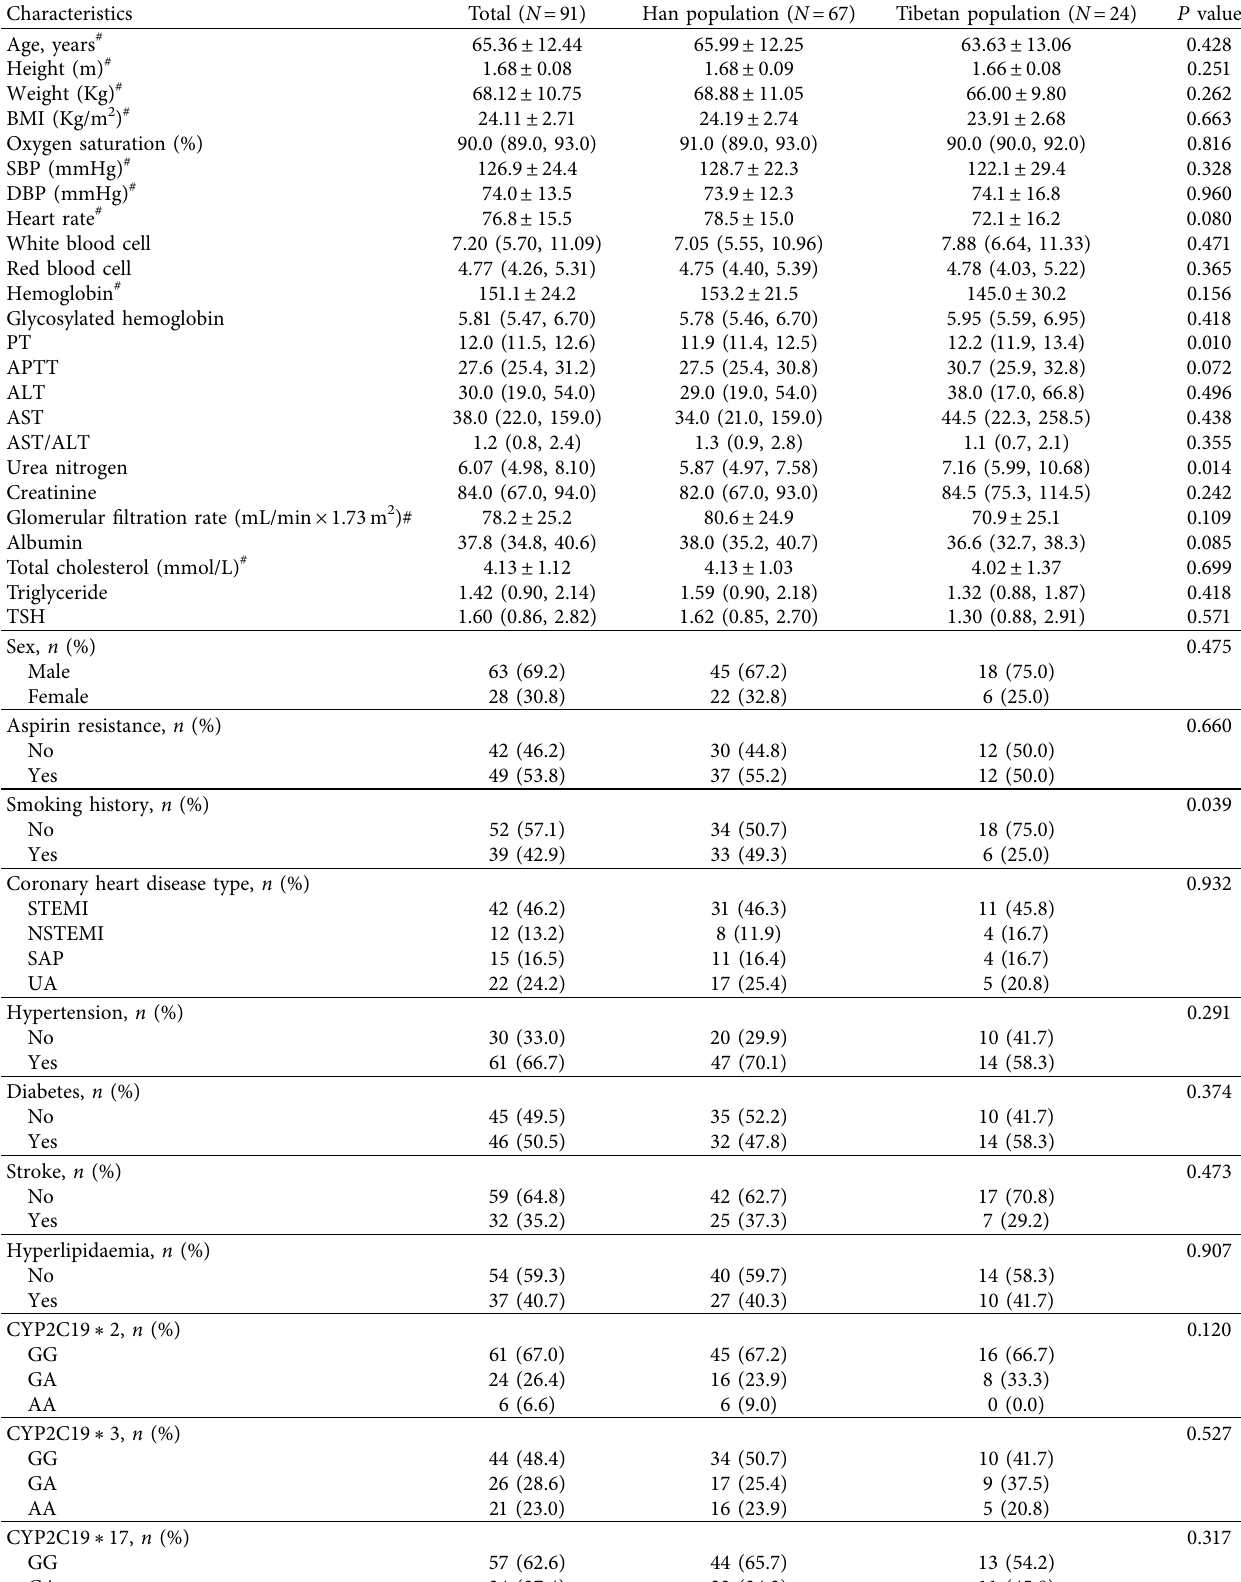
Table 1: Baseline information for